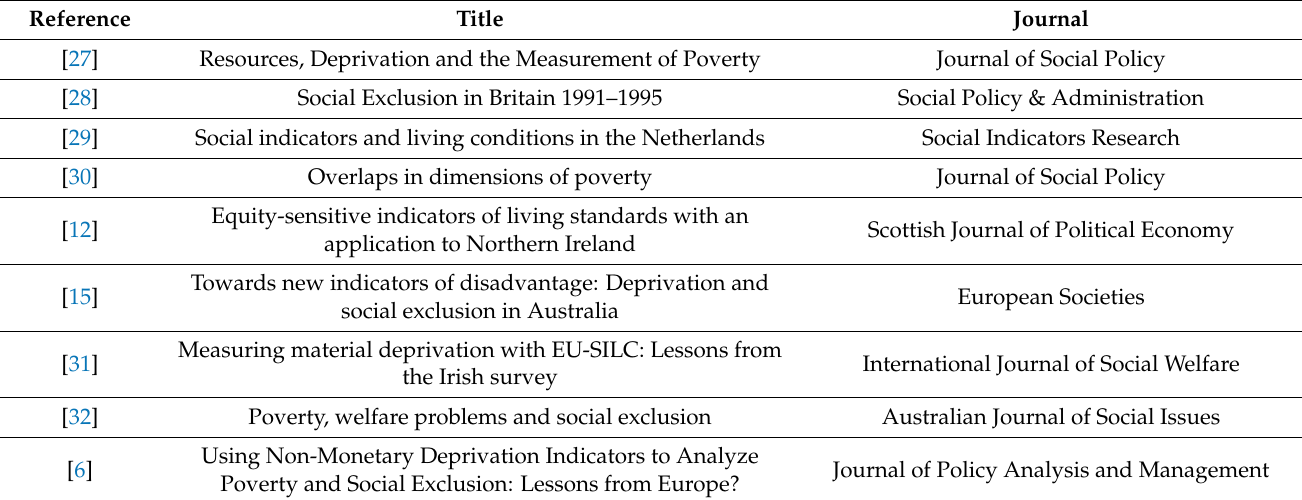
Table 2. Articles included in the